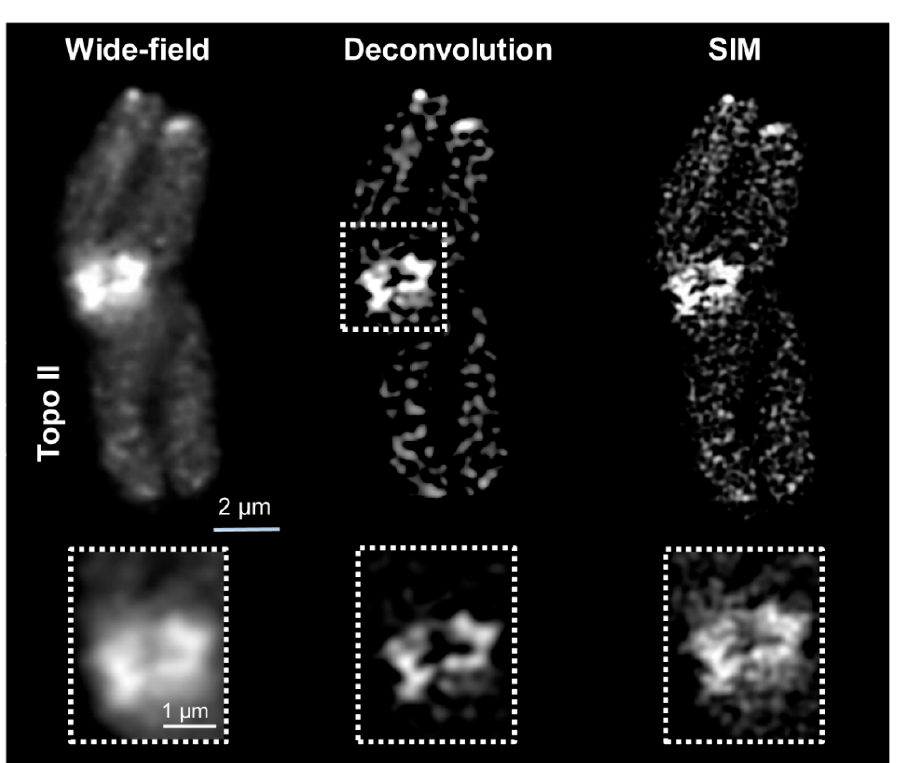
Figure 2. Distribution of Topo II visualized by wide-field, deconvolution, and SIM using STAR635P-labeled secondary antibodies designated for STED. The enlarged regions (dashed rectangles) show clearly the improved resolution achieved via SIM. Only one representative slice from the Z image stack is shown in all images.